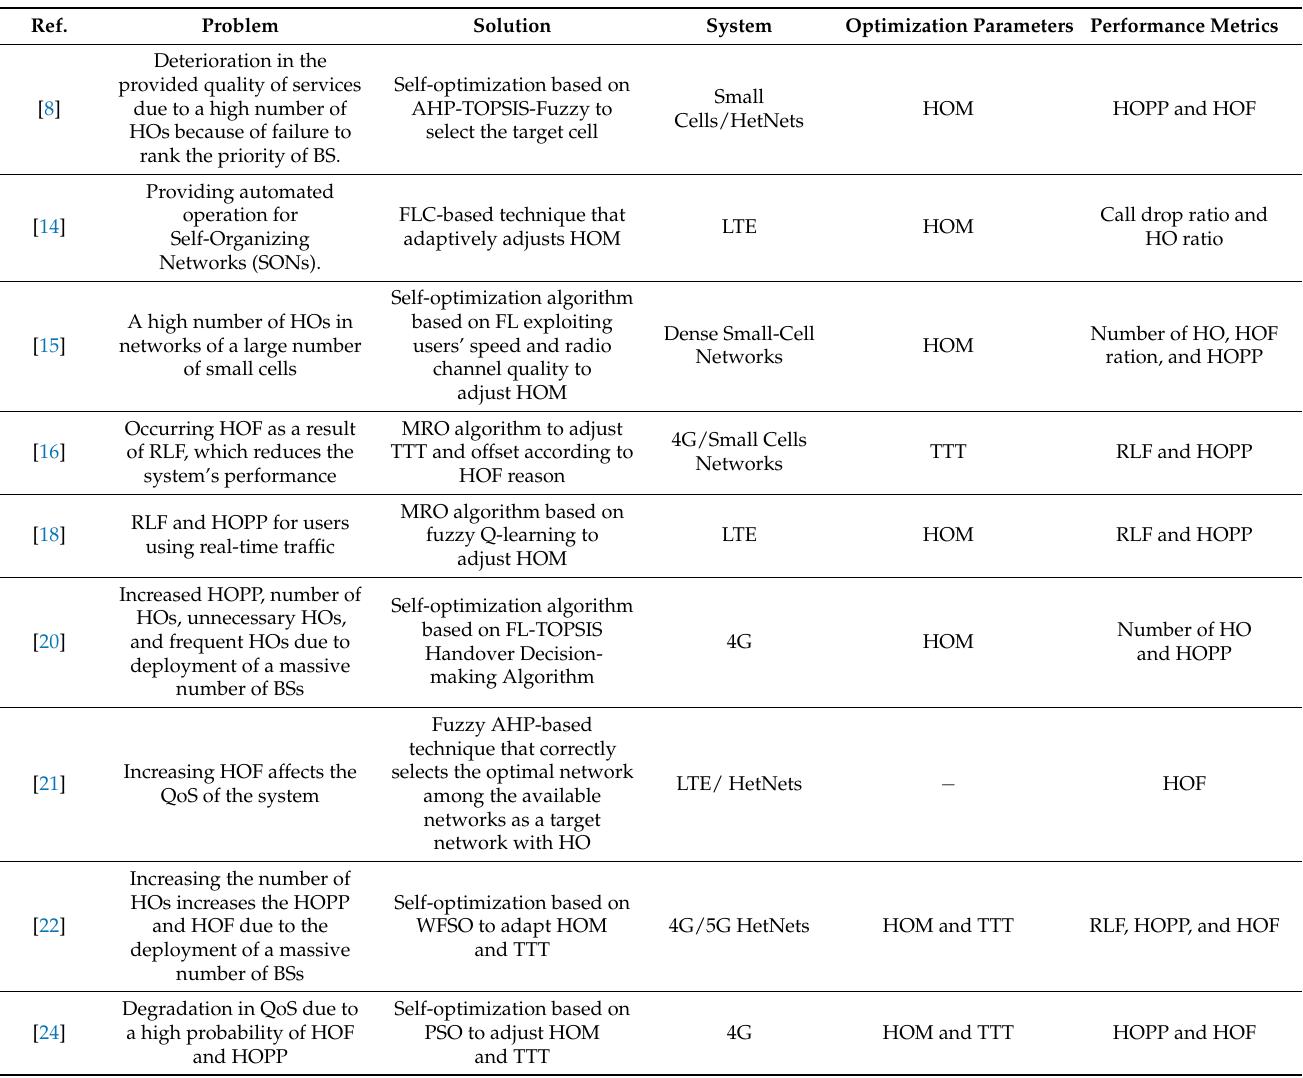
Table 1. Summary of Related